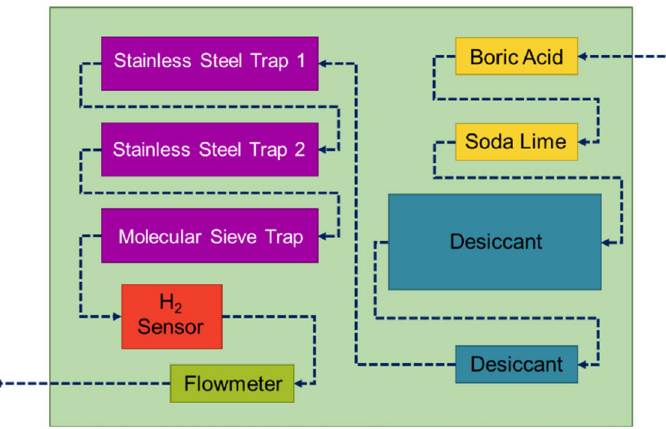
Figure 1. Schematic of the gas line representing the trapping components and measurement probes in the order the purge gas travelled